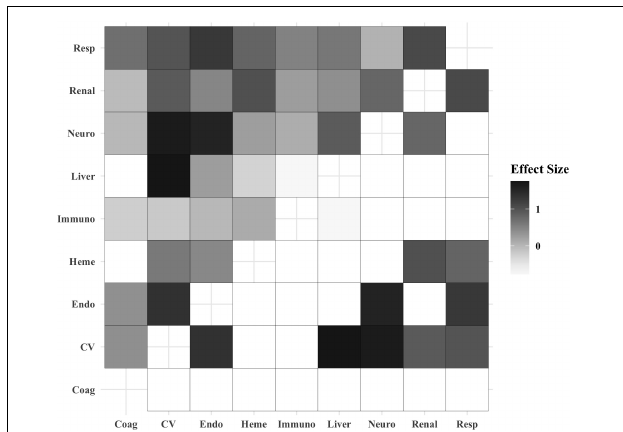
FIGURE 2 | Heatmap displaying the effect size of organ dysfunction interactions and association with mortality. The boxes in the top-left half of the heatmap include the effect size for all of the organ dysfunction interactions based on their coefficients. The boxes in the bottom-right half of the heatmap display only the effect size for the statistically significant organ dysfunction interactions. The white boxes in this half of the heatmap were non-significant and therefore not shaded. Increased box shading indicates a stronger effect size. Coag, coagulation; CV, cardiovascular; Endo, endocrinologic; Immuno, immunologic; Heme, hematologic; Neuro, neurologic; Resp, respiratory.